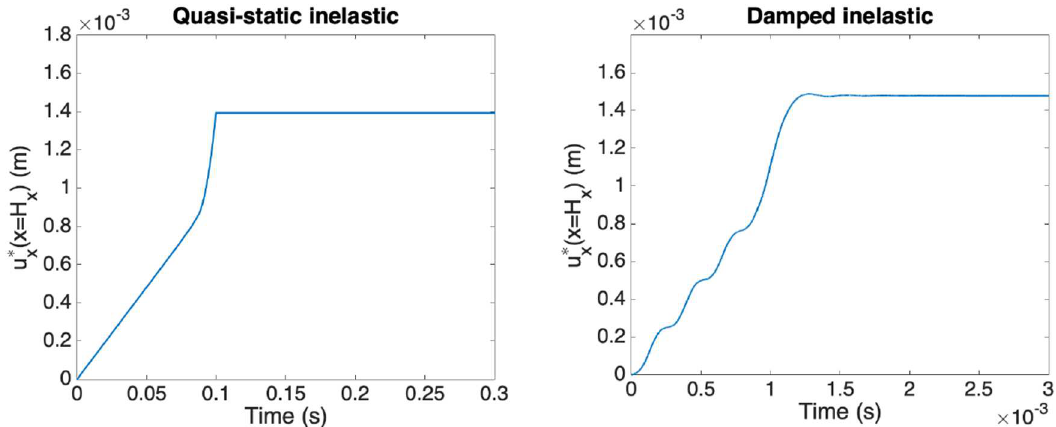
Fig. 20. Quasi-static (left) versus explicit damped (right) in the inelastic case.